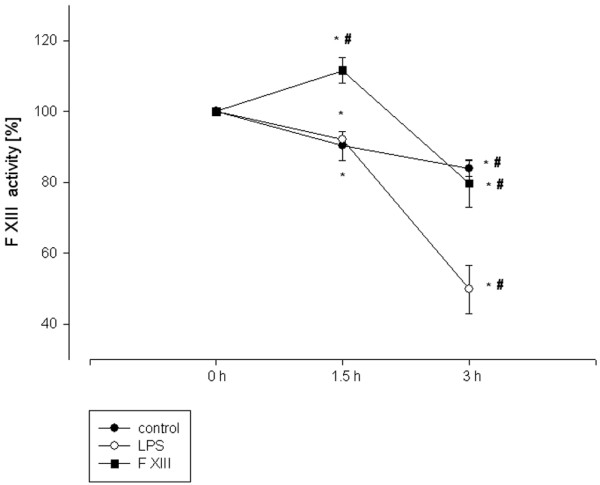
Factor XIII activity (percentage of baseline values, mean ± standard error of the mean; *p < 0.05 compared to baseline; #p < 0.05 compared to lipopolysaccharide (LPS) group). Control, control group; F XIII, factor XIII treated LPS group; LPS, untreated LPS group.